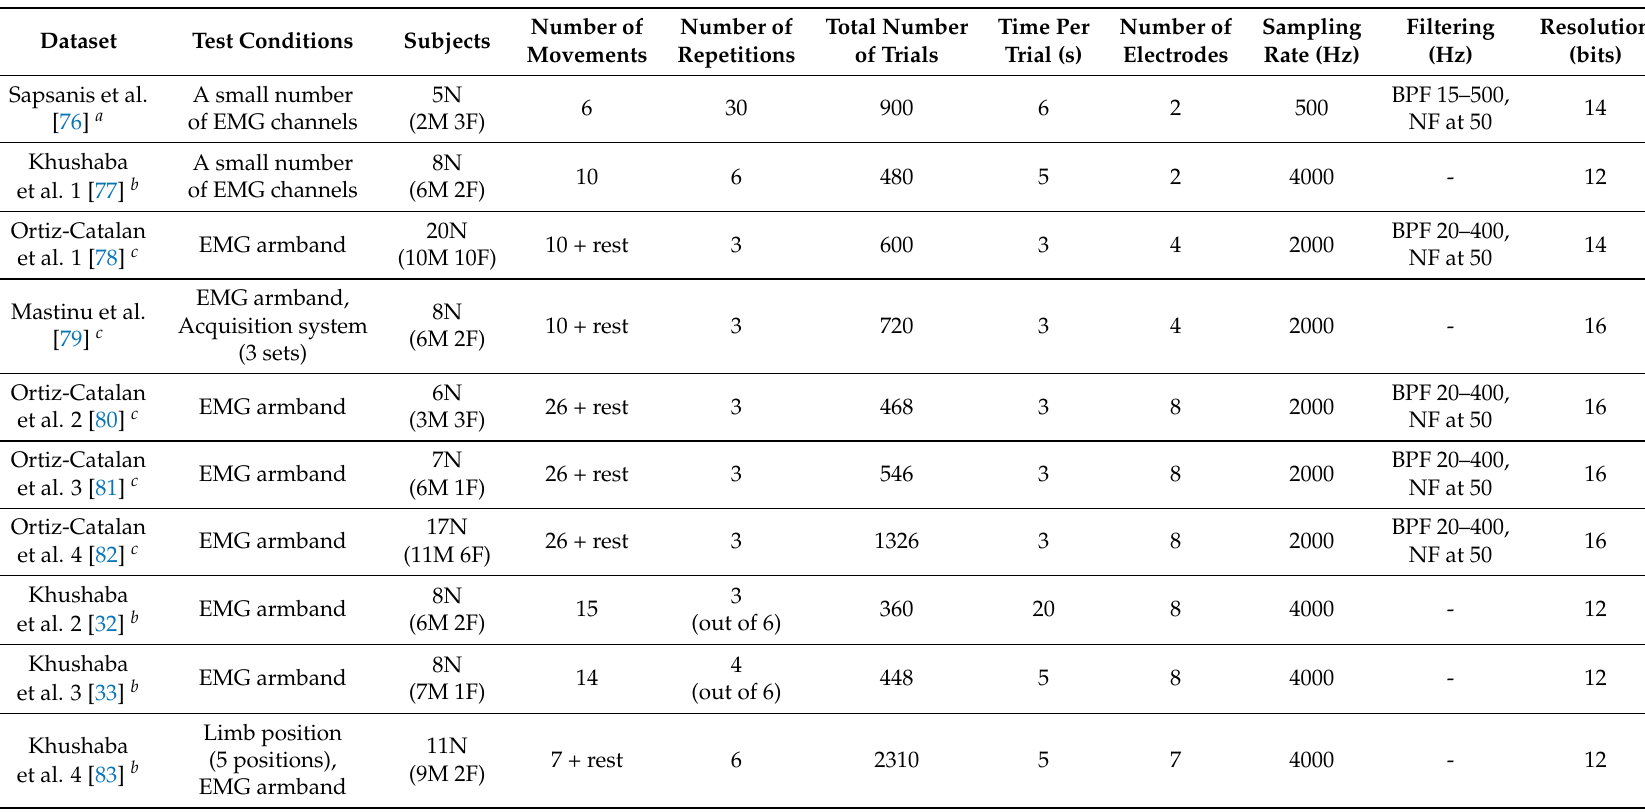
Table 1. Multiple electrocardiogram (EMG) data sets for myoelectric control: subject, experimental protocol, acquisition setup, and pre-processing